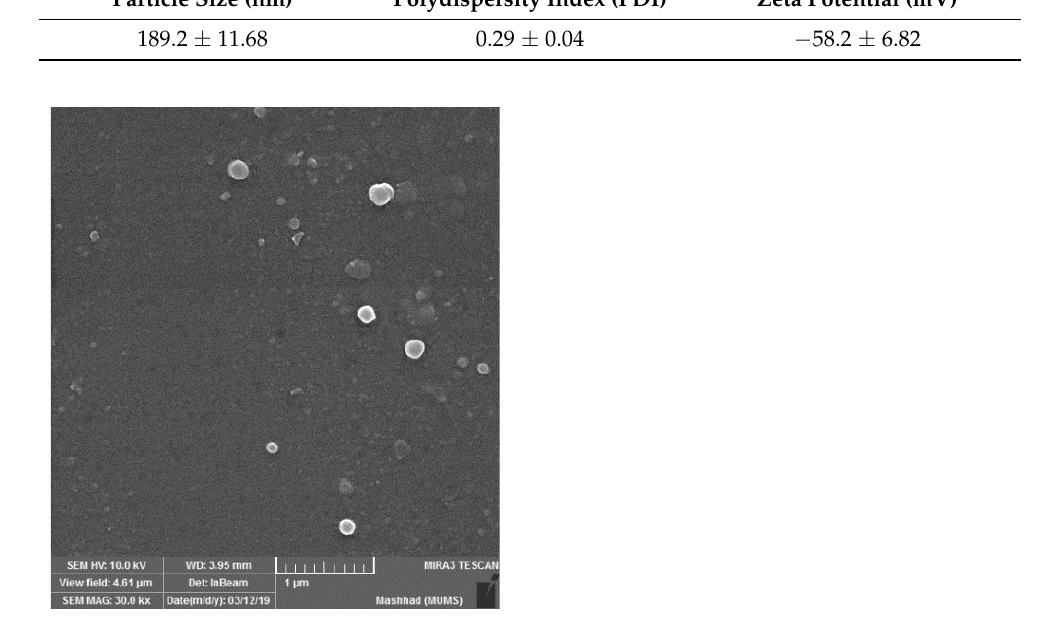
Figure 1. Field emission scanning electron microscopy analysis of nanoliposome loaded by Nastur- tium Officinale.